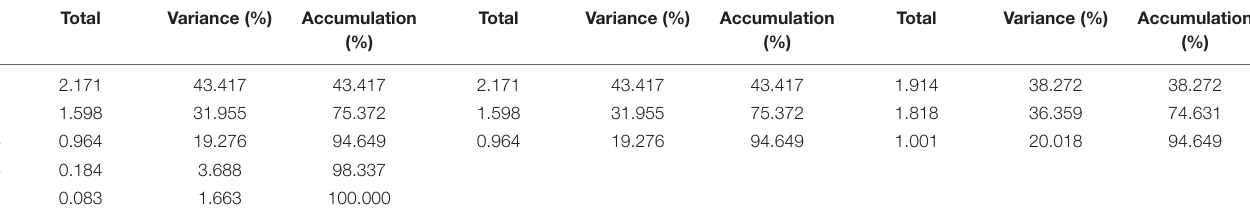
TABLE 2 | Population variance of